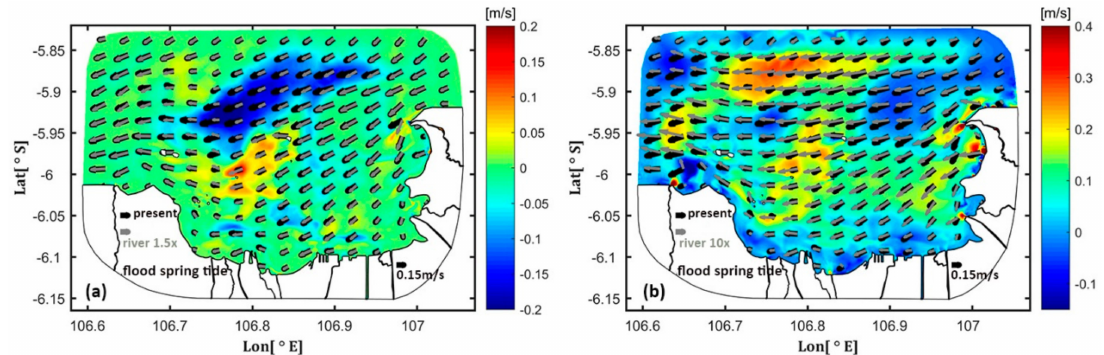
Figure 8. Di ff erences in surface current velocity (m / s) and direction under flood condition spring tide ( a ) scenario 1a and ( b ) scenario 1b. Black vectors are for scenario 1, and grey vectors are for scenario 2a / 2b. Color contours indicate the change in magnitude (m / s) of the surface current